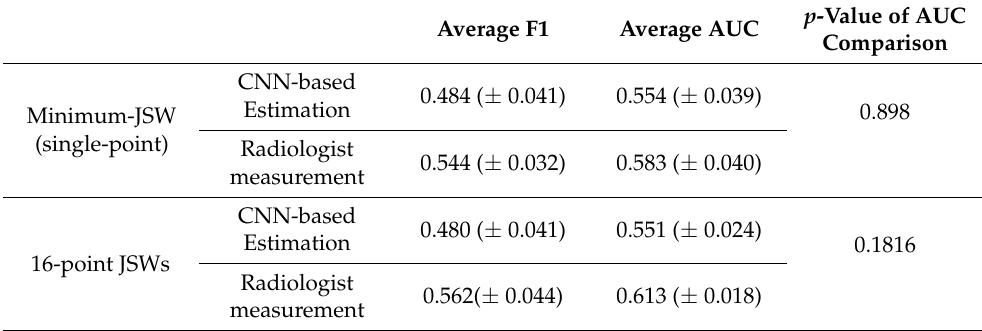
Table 3. KL-progression prediction performance using minimum-JSW and 16-point JSWs from radiologist measurements or CNN-based estimation using XGBoost model. The error represents the 95% confidence interval with the p -value of the t -test reported for comparison between CNN-based estimation and radiologist